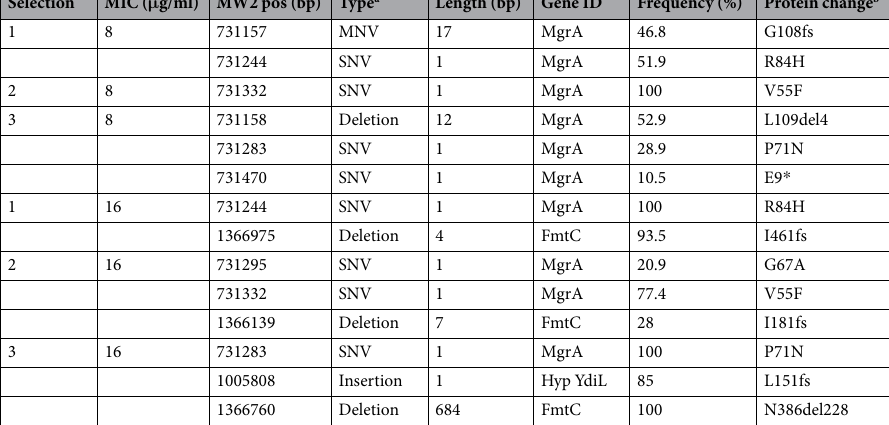
Table 3. Mutations identified in HMPC-resistant S. aureus mutants selected in vitro . a MNV = Multi-nucleotide variant; SNV = Single Nucleotide Variant. b fs = frame-shift; * stop codon.